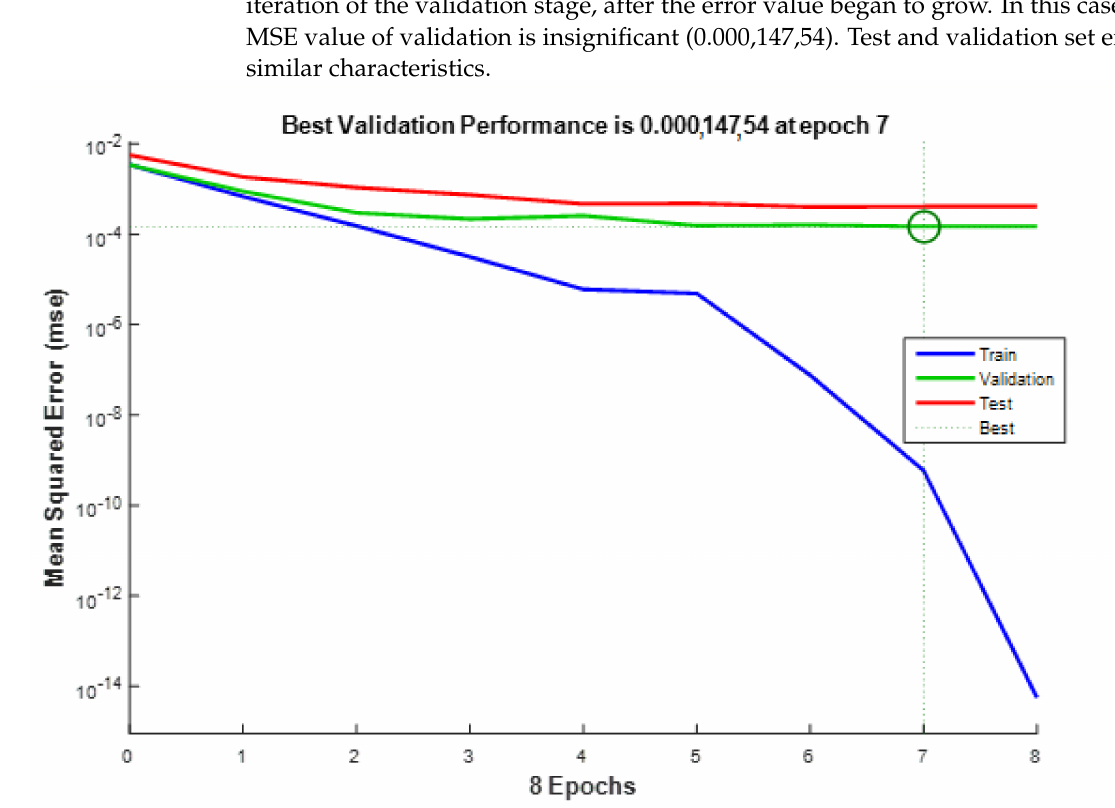
Figure 5. ANN performance (by the